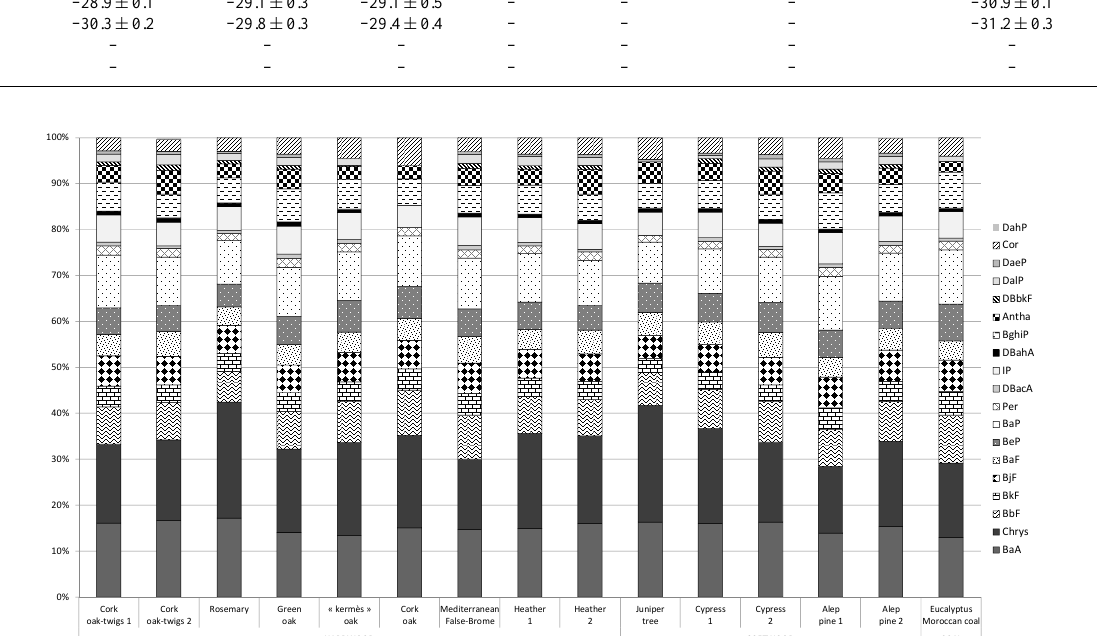
Fig. 2. Molecular fingerprints of particulate-PAHs from wood combustion.